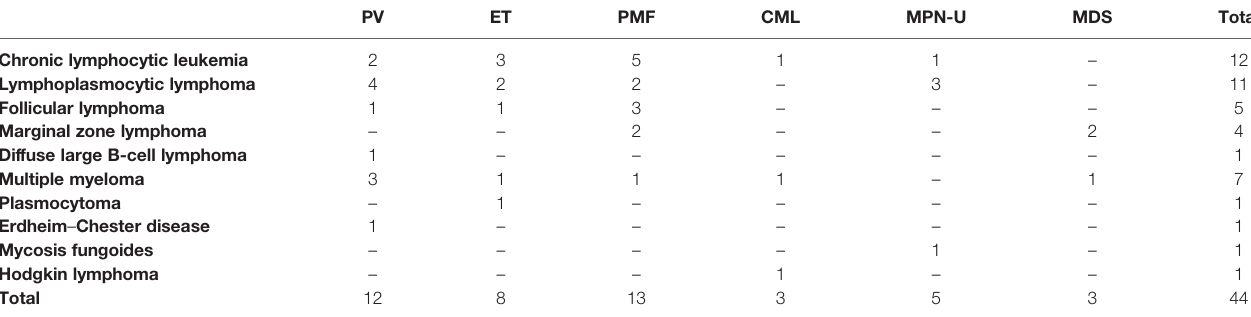
TABLE 2 | Overview of the associated myeloid and lymphoid